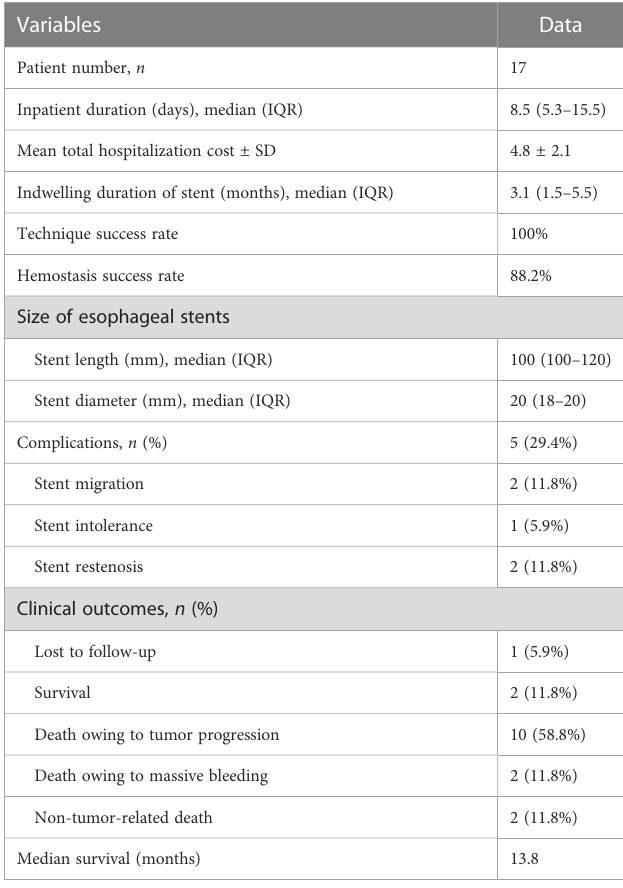
TABLE 2 Clinical data on stenting.